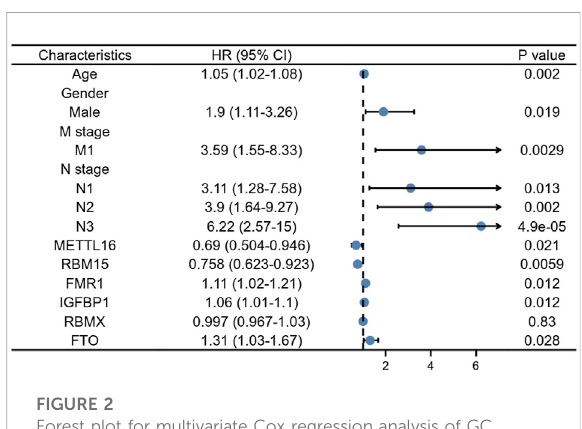
FIGURE 2 Forest plot for multivariate Cox regression analysis of GC patients in the training